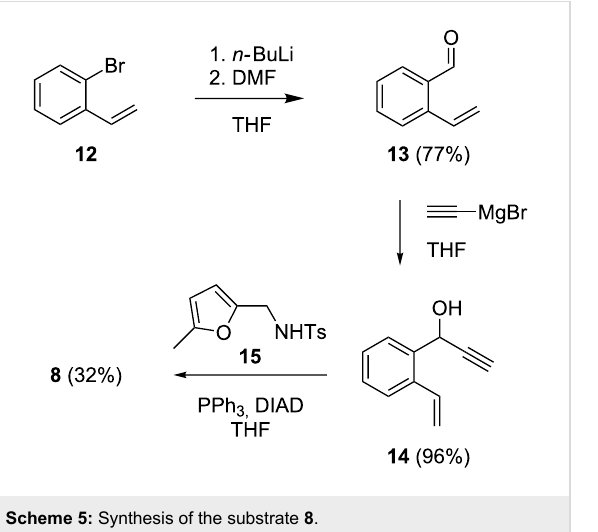
Scheme 5: Synthesis of the substrate 8 .